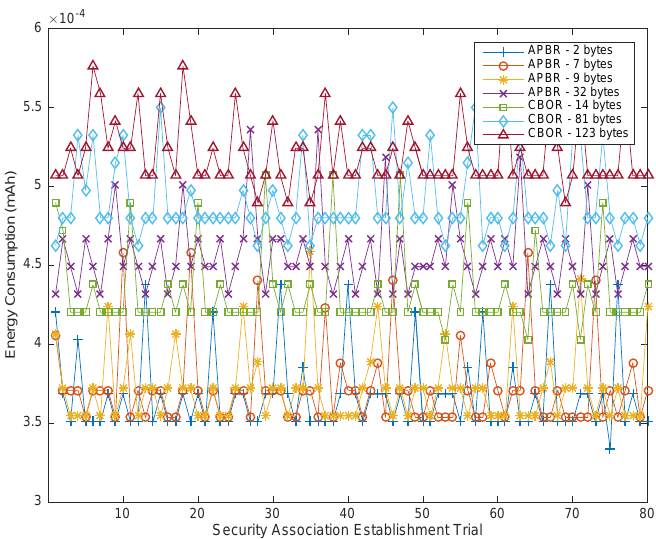
Figure 9. Energy consumption in security association establishment considering 80 requests in a one-hop network configuration.